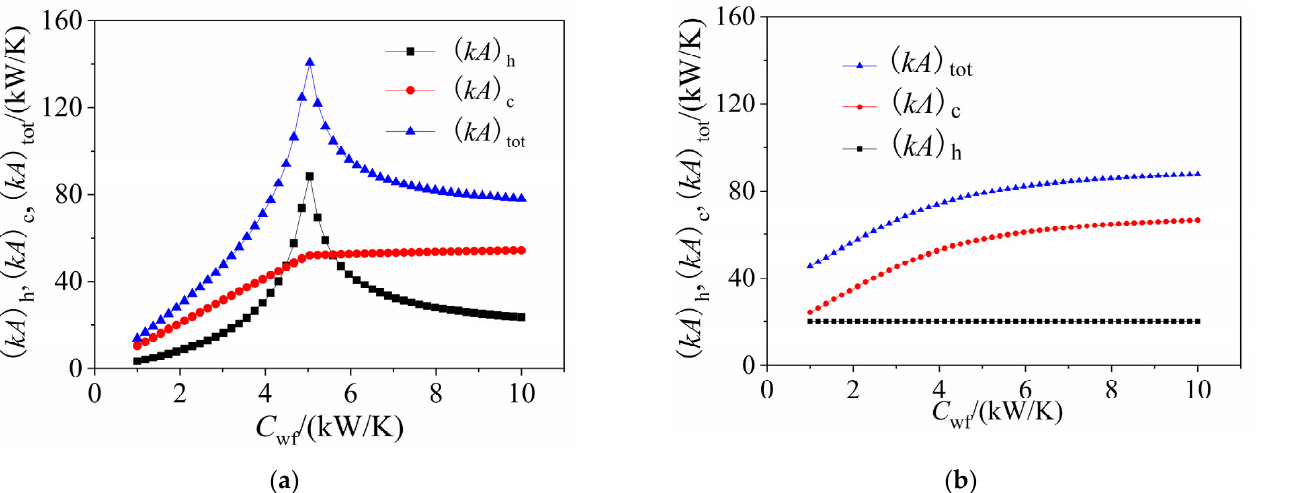
Figure 7. The impact of C wf on the heat transfer capacity of the system: ( a ) ε remains constant; ( b ) ( kA ) h remains constant. ( b ) ( kA ) h remains